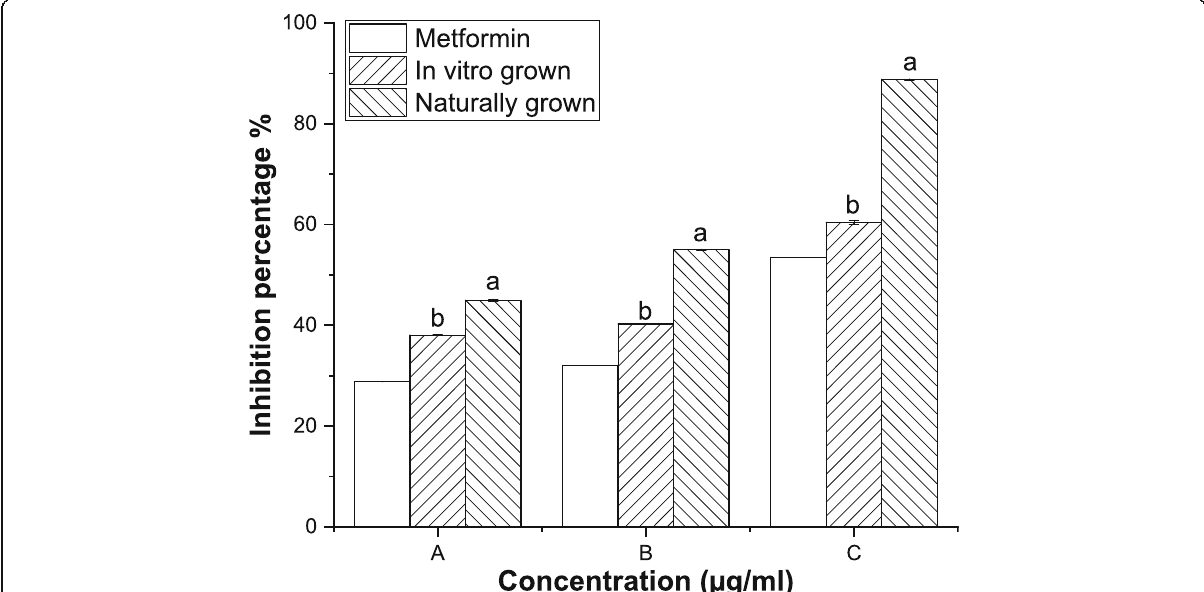
Fig. 5 α -glucosidase inhibitory activity of in vitro and naturally grown L. cruciata and their comparison with standard Metformin . Values with different letters (a, b) are significantly ( p < 0.05) different from each other by Turkey ’ s multiple range test